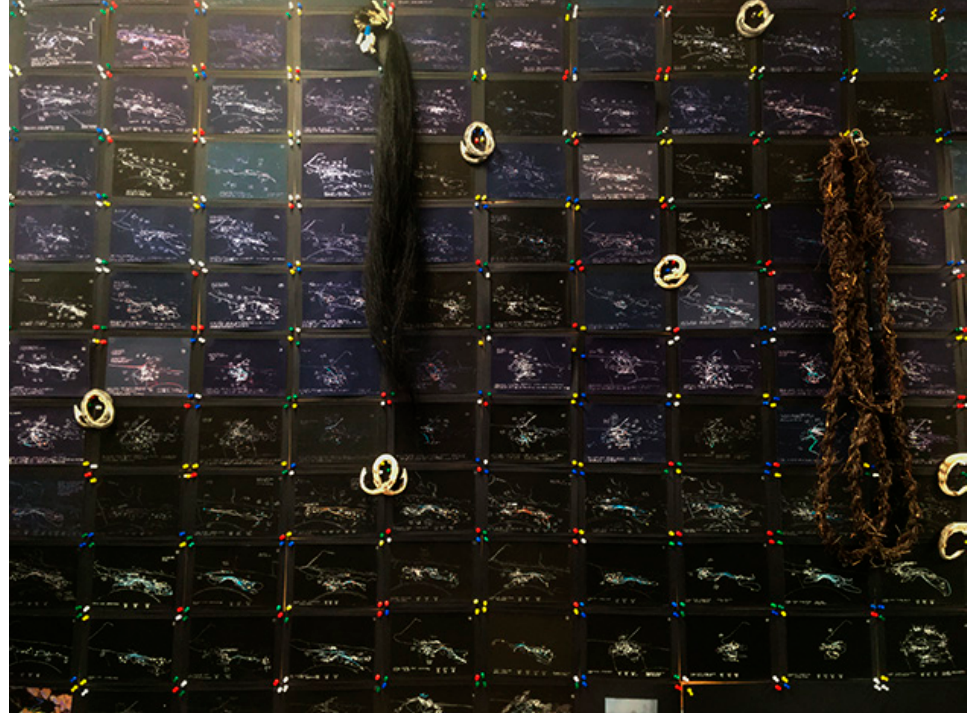
Figure 3. ‘How he moves in the darkness’ (Collins & Goto Studio 2019).